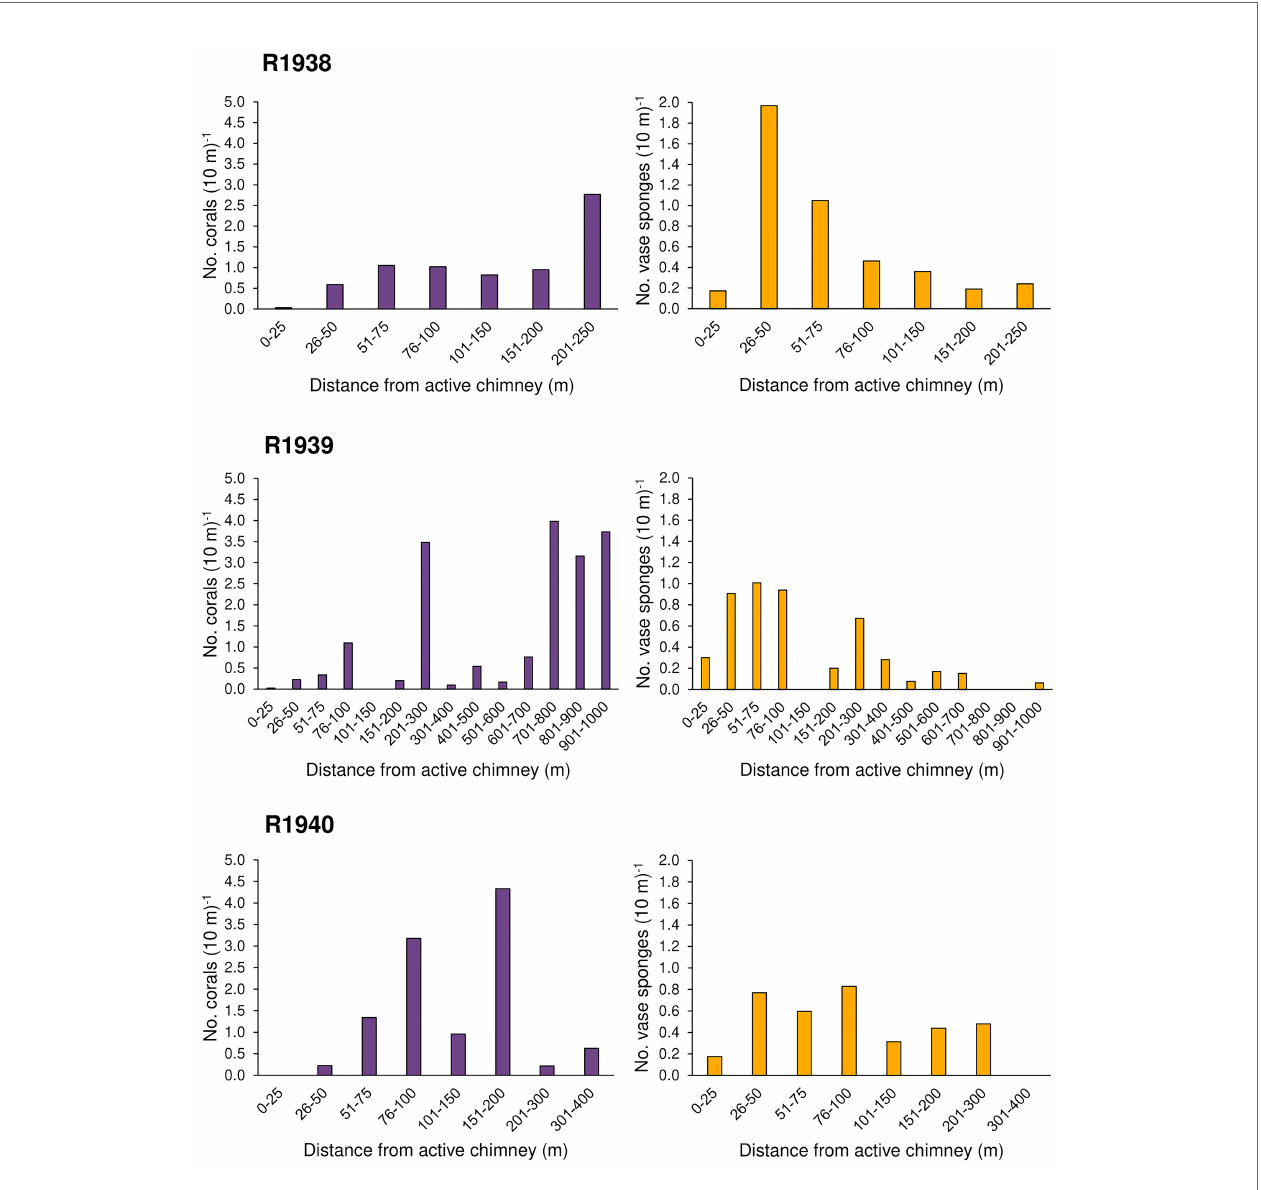
FIGURE 4 | Number of deep-water corals and rossellid vase sponges (Rossellidae) (per 10 m of dive track) occurring within distance categories from active hydrothermal chimneys for each of 3 dives at the Endeavour segment of the Juan de Fuca Ridge, in August 2016. Dive R1941 was not included as no deep-water corals and only three rossellid vase sponges were recorded. Distance to the closest active feature was calculated in ArcGIS Pro (see